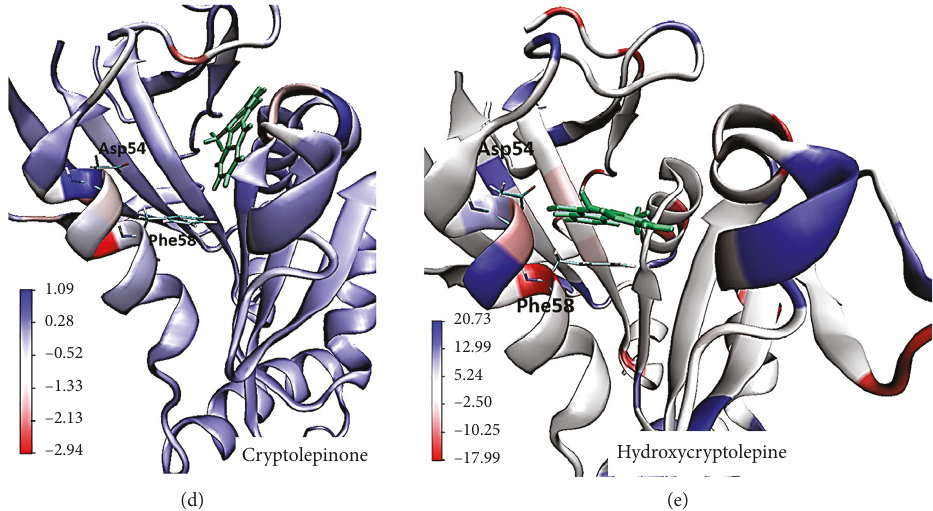
Figure 9: Binding conformation predicted from molecular docking was generally stable under dynamic conditions; except for crypto- heptine and cryptolepinone. (a) Trajectory showing stability of protein ligand complexes for wild-type Pf DHFR. Biscryptolepine (light green) and cryptoheptine (blue) followed a similar extent of deviation, however, achieved overall stability between 8 ns and 50ns. Cryptolepinone-wt- Pf DHFR complex was least stable before 30ns, after which a more stable conformer was obtained within the binding site. Interacting residues contributing to binding affinity have been colored based on b-factors (b-e). Leu46, Cys50, Met55, Tyr57, Phe58, Glu110, Ser111, Ile112, and Pro113 interacted mostly with ligands contributing somewhat to determined binding free energy. Asp54 contributed weakly to ligand